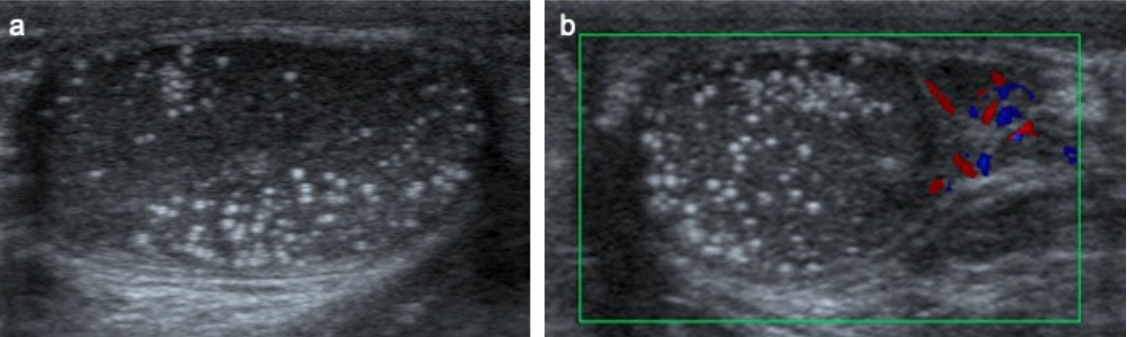
Figure 15. Testicular microlithiasis in a 6-year-old boy. Transverse gray-scale B-mode ( a ) and color Doppler ( b ) US of the scrotum. Images show diffuse hyperechoic punctate calcifications.